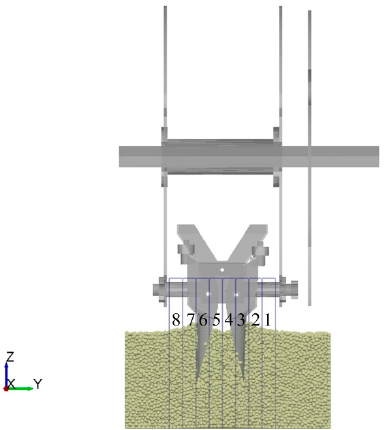
Figure 11. Diagram of the horizontal monitoring area layout. Notes: 1–8 are various monitoring zones.